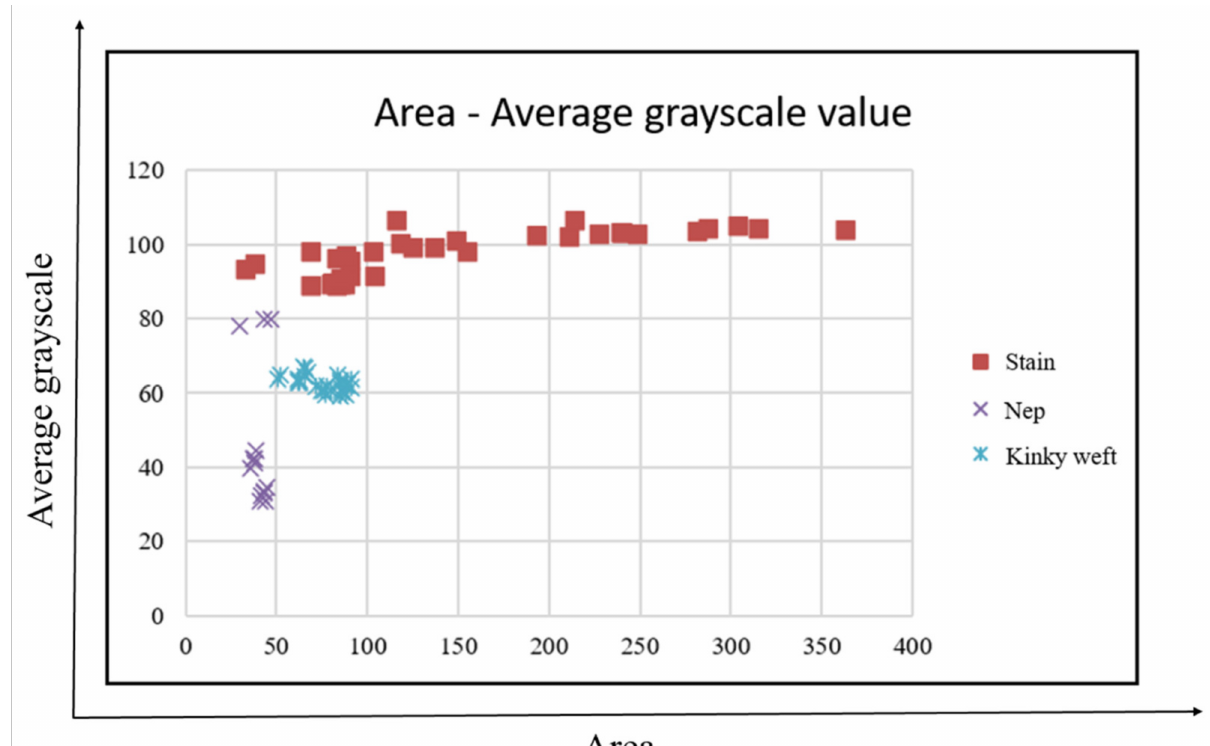
Figure 13. Area vs. average grayscale value feature